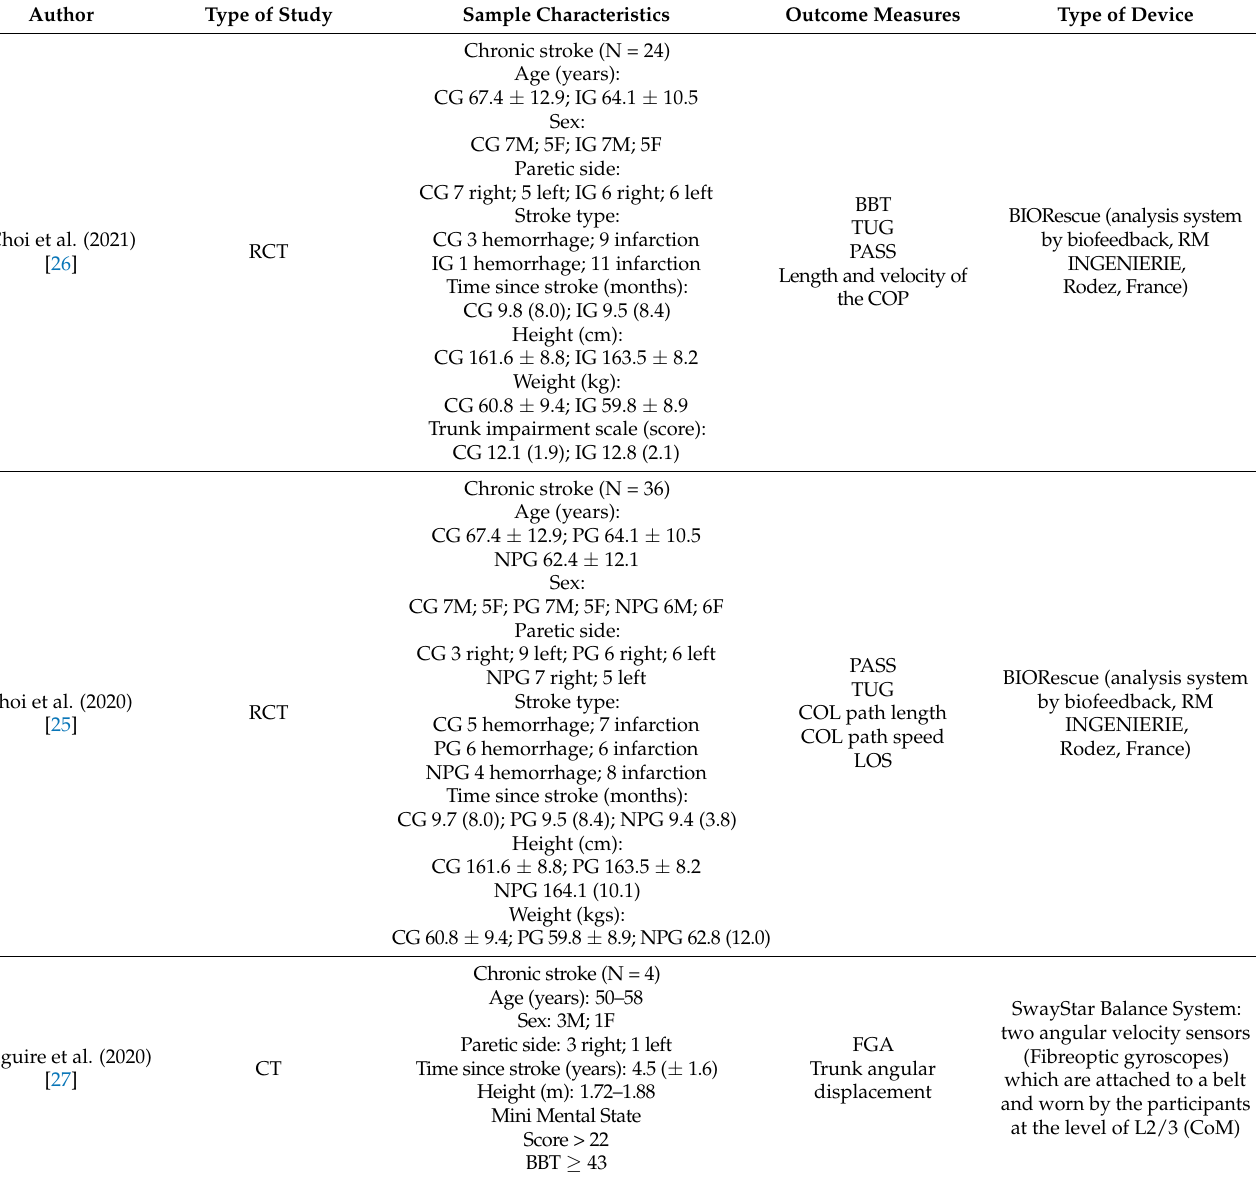
Table 1. Summary of the